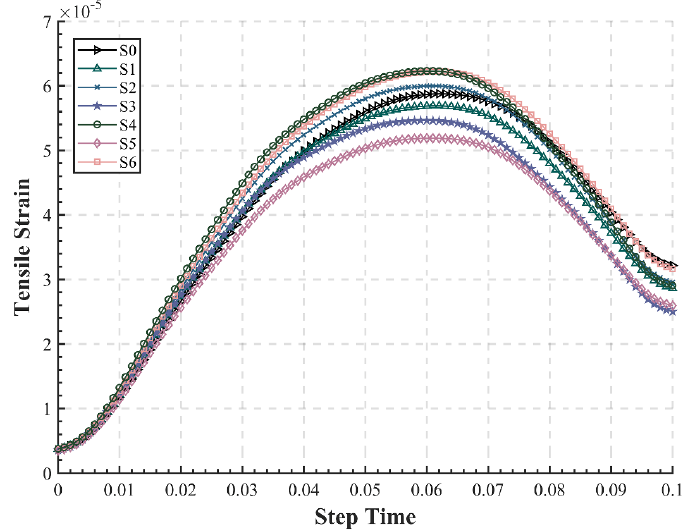
Figure 5. Time–history curve of tensile strain at the bottom of asphalt layer.